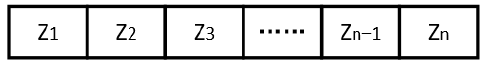
Figure 12. Brake chromosome diagram.